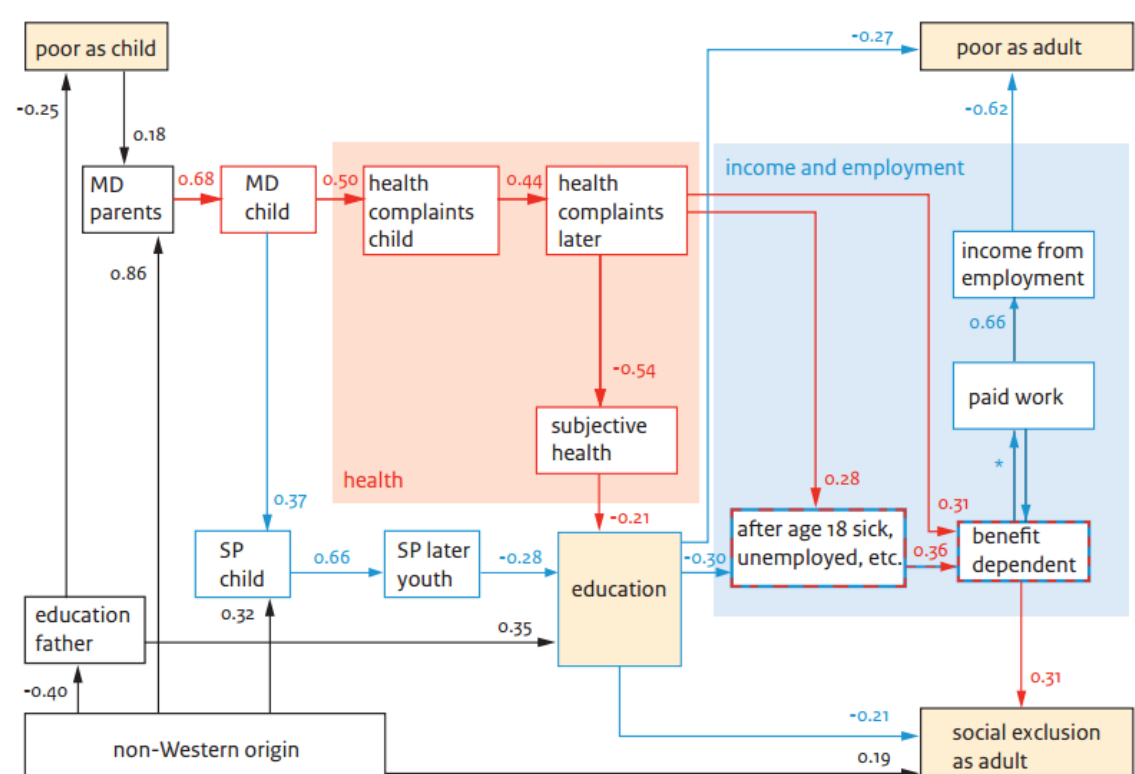
Figure 2. Routes from poverty and social exclusion in childhood to adult life (main standardised effects). Notes: MD = material deprivation; SP = social participation ; * The unstandardised effect was constrained to be equal in the model; after standardisation the parameter values are unequal: paid work = -0.56 (benefit dependent); benefit dependent = -0.08 (paid work). Source: ASOUK’09 data set; Guiaux et al.